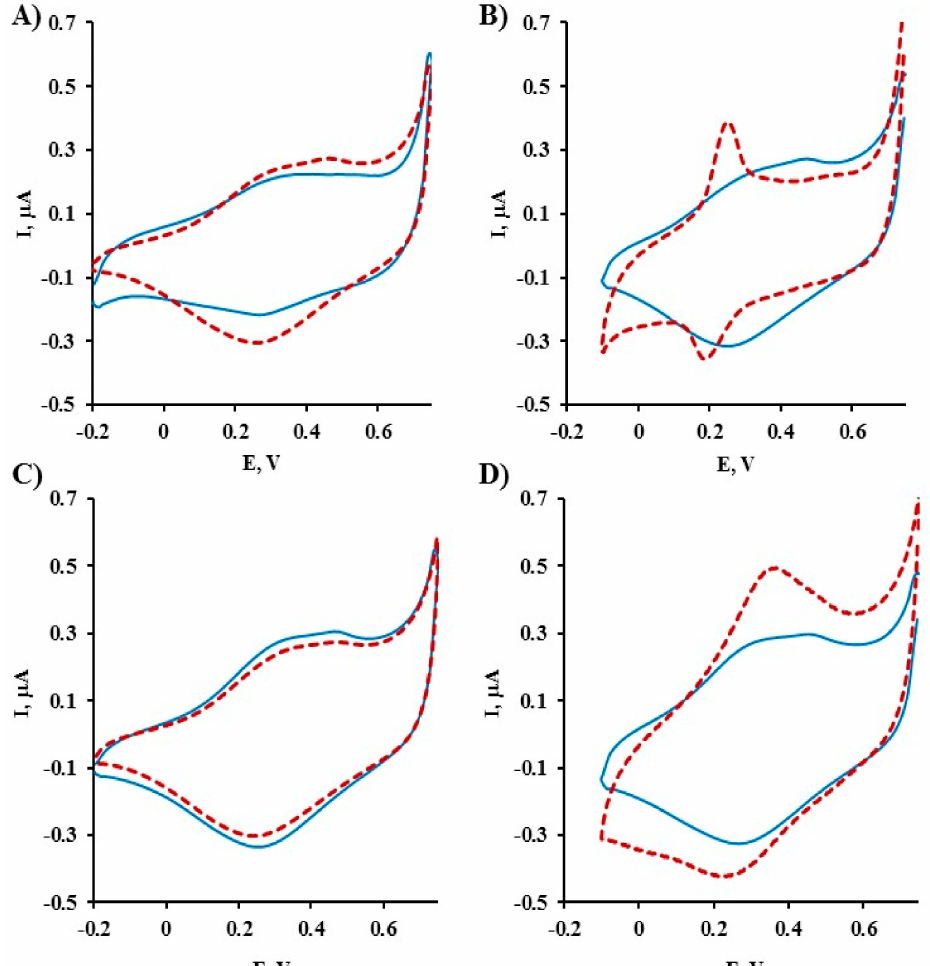
Figure 1. Representative cyclovoltammograms obtained for the gold electrode modified with: ( A ) TPY (solid line) and TPY / Co(II) (dashed line) ( B ) TPY (solid line) and TPY / Cu(II) (dashed line) ( C ) DPM (solid line) and DPM / Co(II) (dashed line) ( D ) DPM (solid line) and DPM / Cu(II) (dashed line) Bu ff er conditions: PBS pH 7.4, Scan rate: 100 mV /